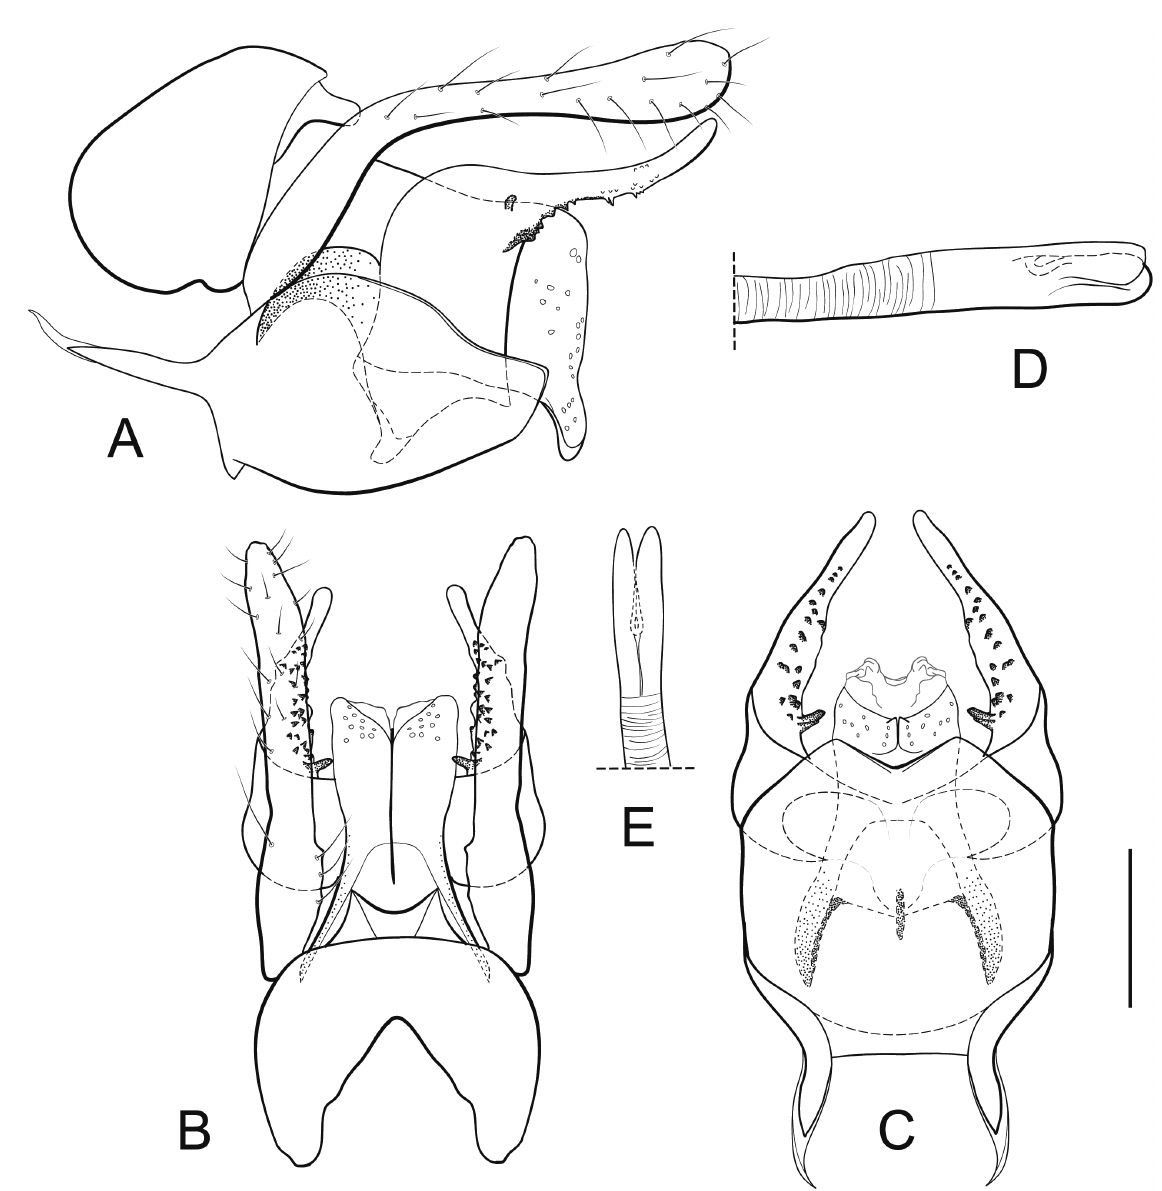
Fig. 5. Xiphocentron ( Antillotrichia ) maracanan sp. nov., holotype, adult, ♂, genitalia. A . Left lateral view. B . Dorsal view. C . Ventral view. D . Phallus apex, left lateral view. E . Phallus, apex in dorsal view. Scale bar = 0.1